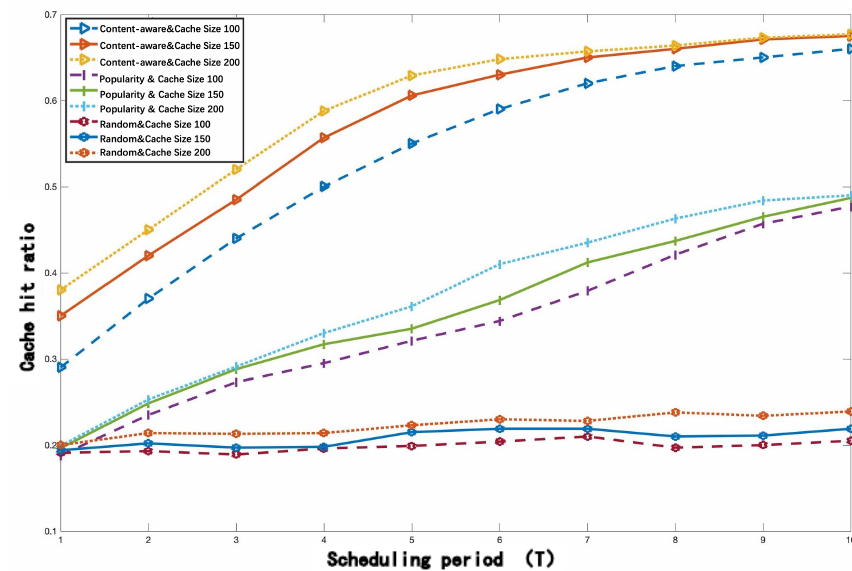
Figure 7. Cache hit rate comparison